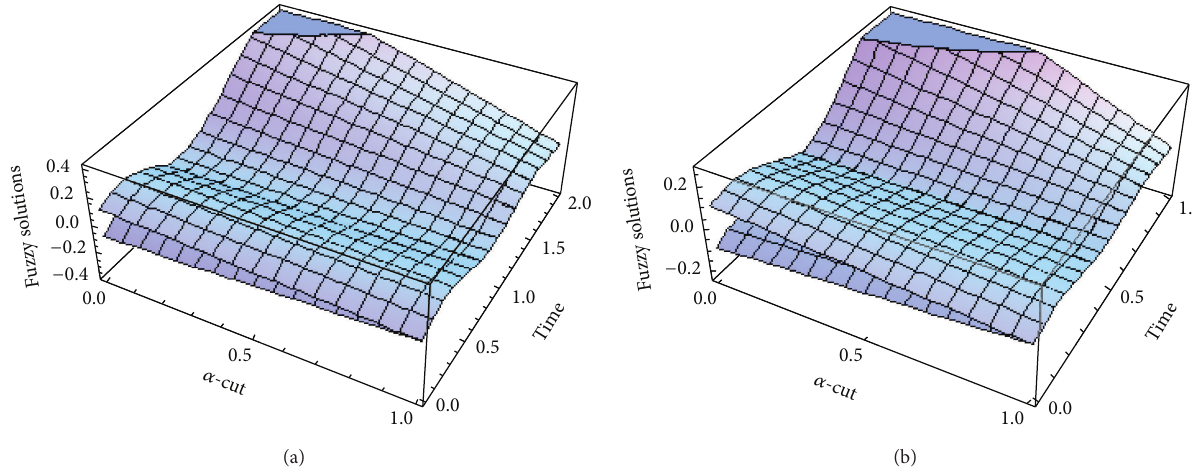
Figure 2: Fuzzy responses at 𝑥 = 1/2 with natural frequency (a) 𝜔 = 5 rad/s and (b) 𝜔 = 10 rad/s and damping ratio 𝜂 = 0.05 for unit impulse